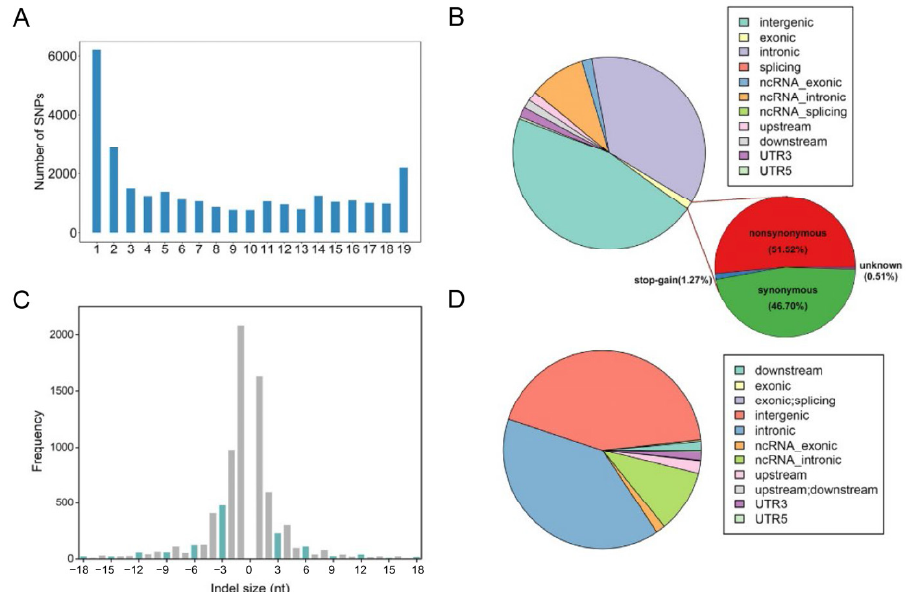
Figure 2. Distribution of SNVs by location and type. ( A ) Frequency distributions in terms of occurrences in 19 cases. ( B ) Distribution of SNPs by their gene location and type. ( C ) Distribution of indel lengths. ( D ) Distribution of indels by their gene